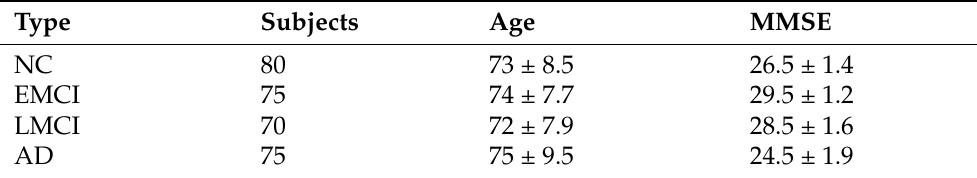
Table 1. Sample size of the dataset utilized for training and testing the